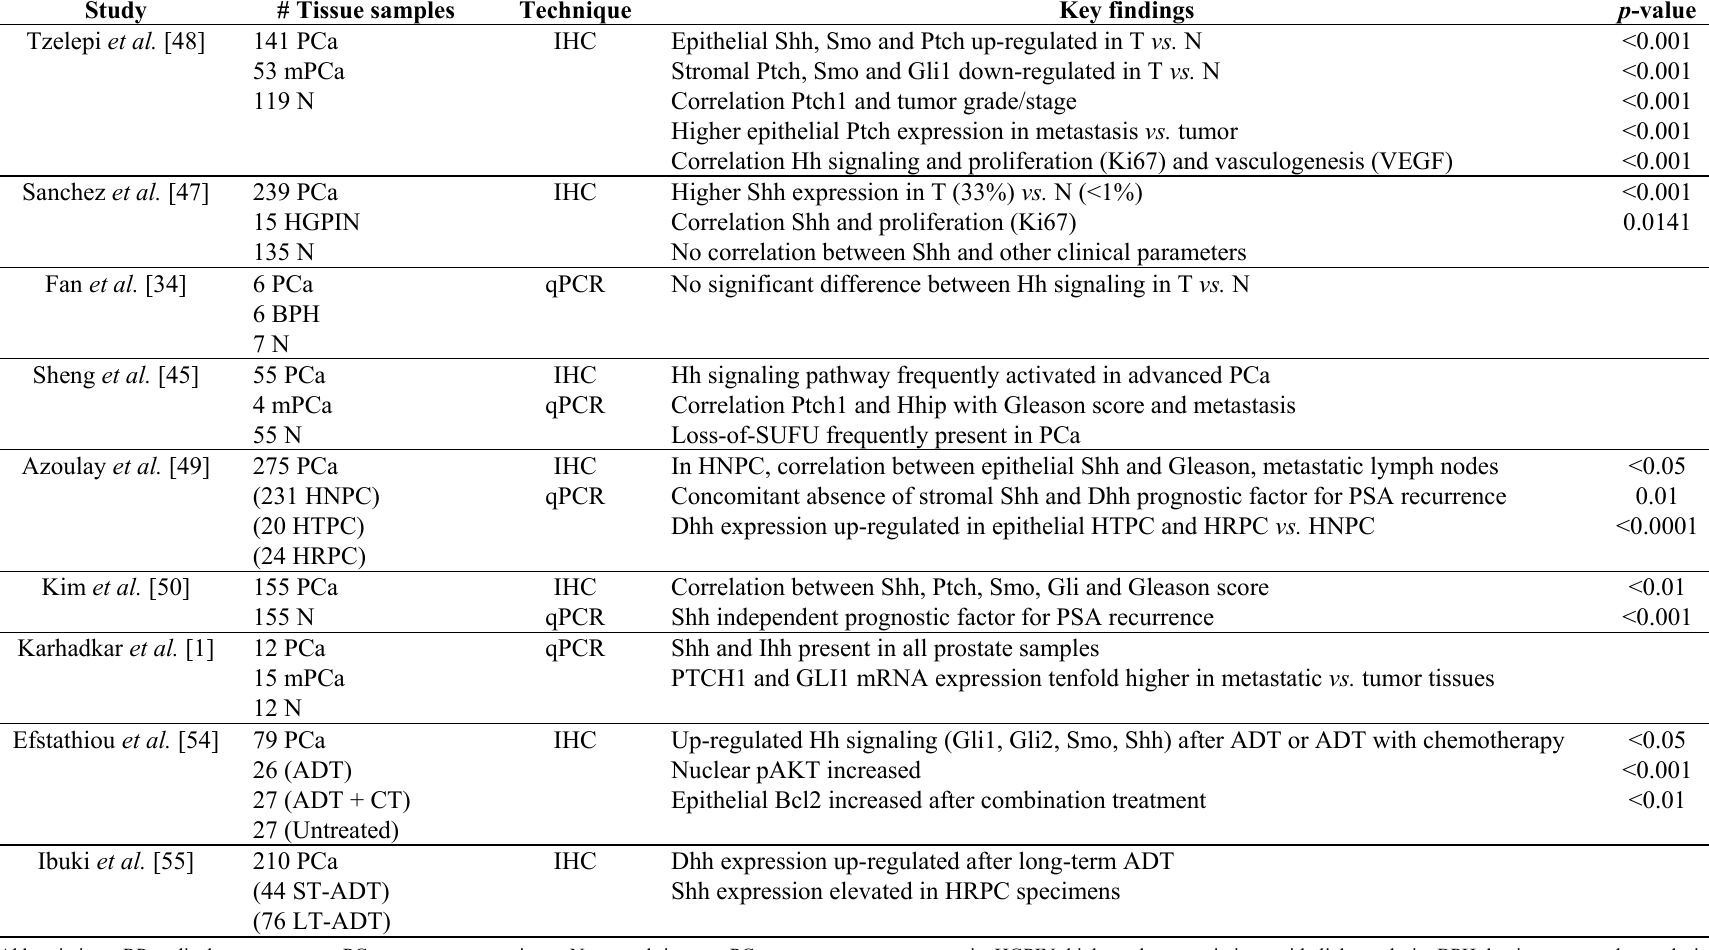
Table 1. Overview of key associations between Hh signaling and clinicopathological parameters in